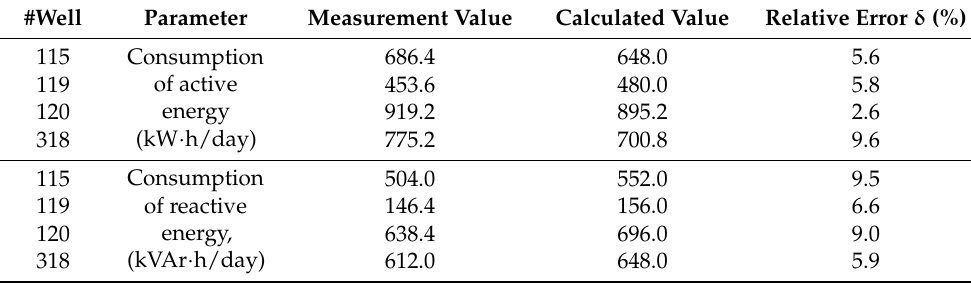
Table 3. Results of measurements and modeling of ESP power